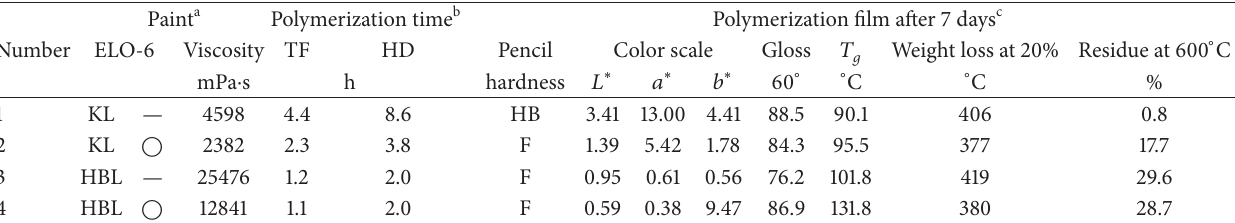
Table 2: Polymerization of lacquer paints with epoxidized linseed oil